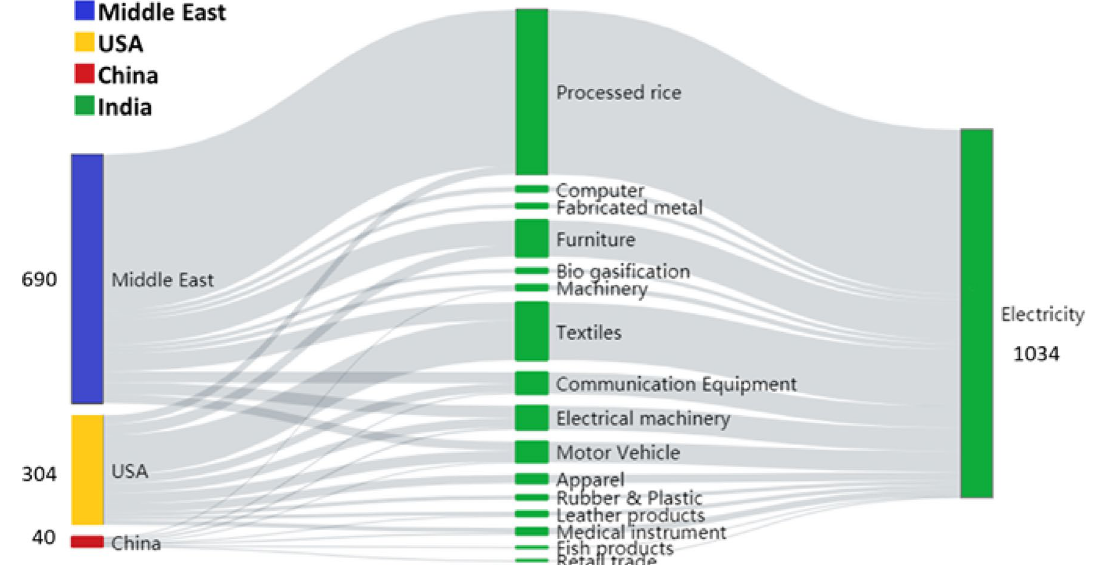
Figure 3. Top 10 supply chain paths ranked in terms of health impact driven by the Middle East, USA, China in the first tier.